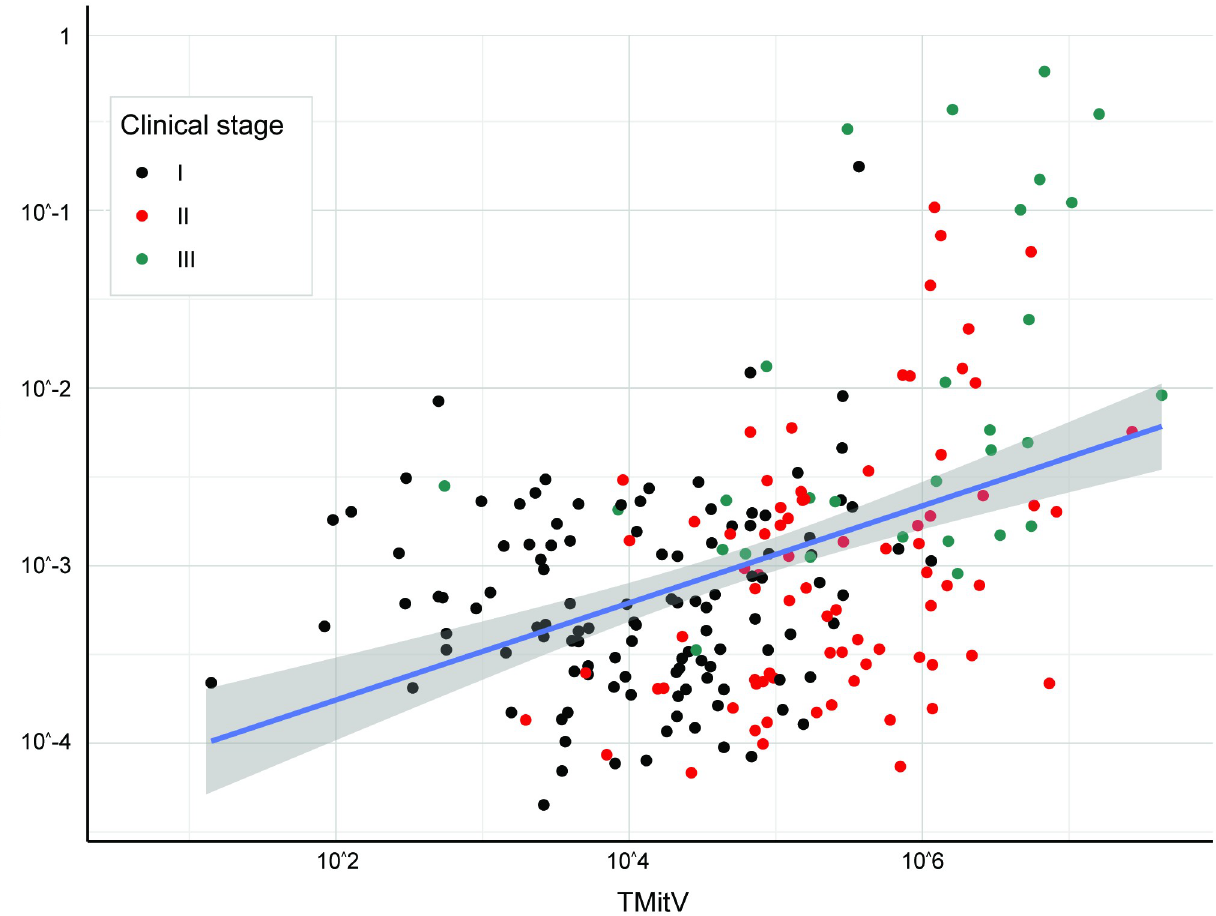
Fig 5. cTF increases with breast cancer tumor mitotic volume. cTF increased with TMitV (in mm 3 ) for breast cancer. Black, red, and green dots depict samples from stages I, II, and II, respectively (Model development and validation was limited to clinical stages I-III). Linear fit and 95% confidence intervals are shown in blue and gray, respectively. cTF: Circulating cfDNA tumor fraction, TMitV: Tumor mitotic volume.